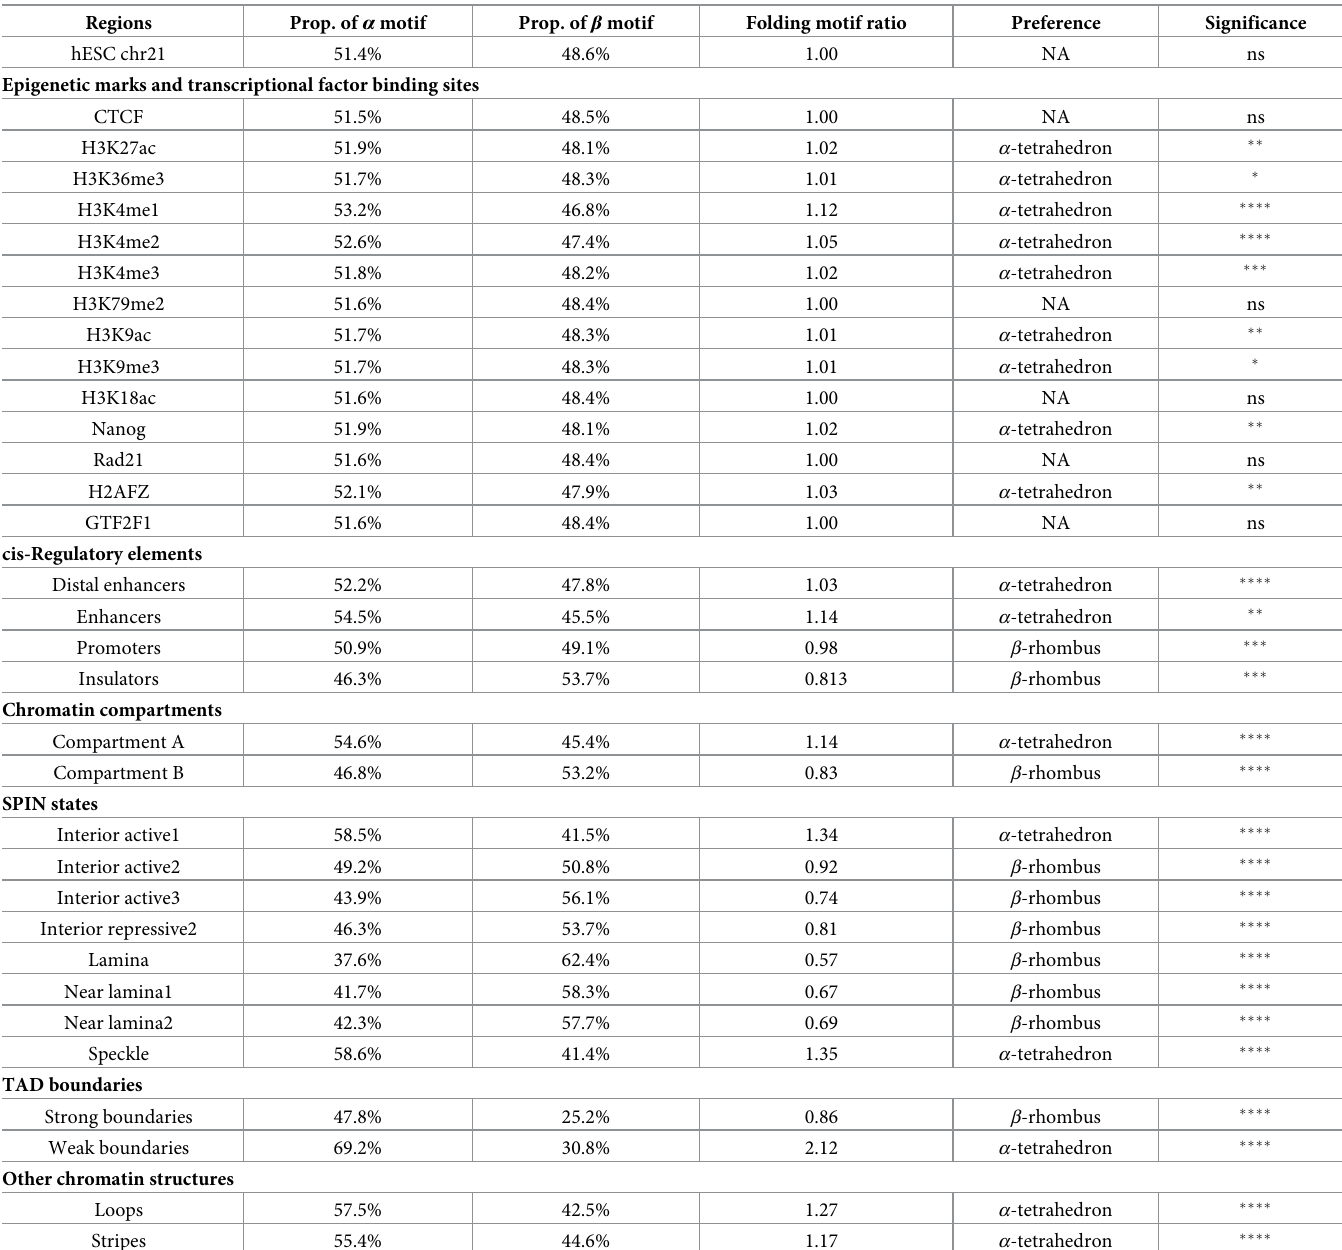
Table 1. Preferences on tetra-nucleosome folding motifs in different regions.